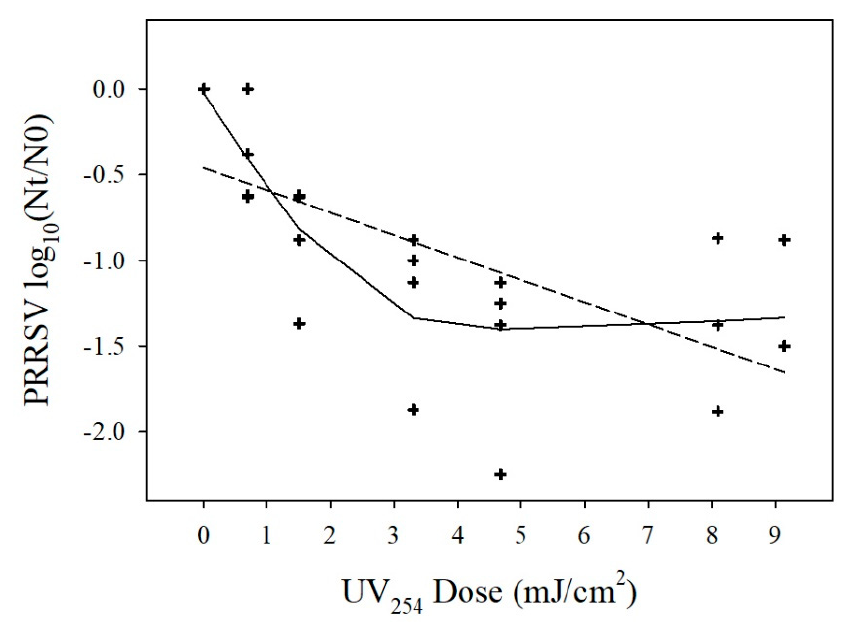
The corrected Figure A1 is: